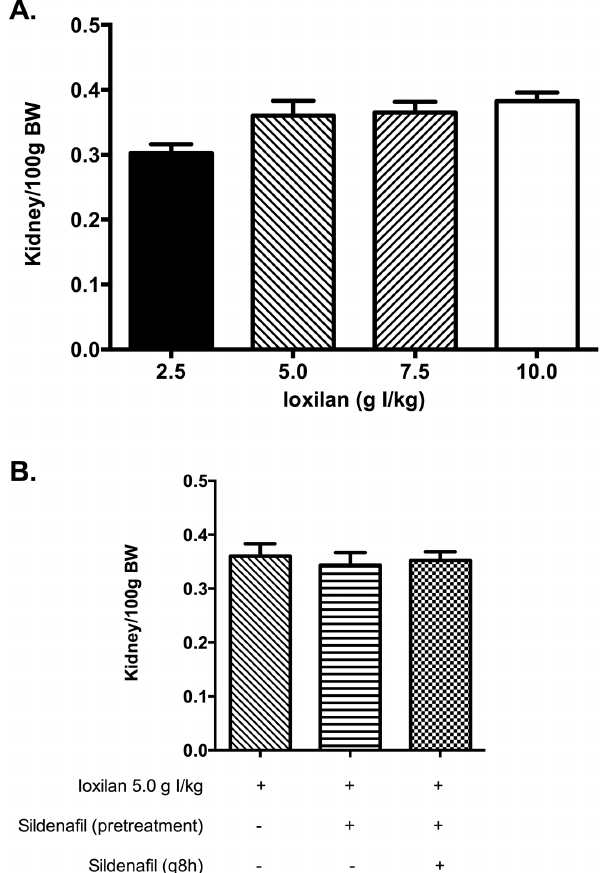
Figure 1. Kidney to body weight ratio analysis in rabbits subjected to CIAKI. The kidney to body weight ratio was measured as the average weight of both kidneys per 100 g body weight. (a) Kidney to body weight ratio for animals treated with increasing doses of CM. (b) Kidney to body weight ratio for animals pretreated with sildenafil citrate (6.0 mg/kg; single dose or q8